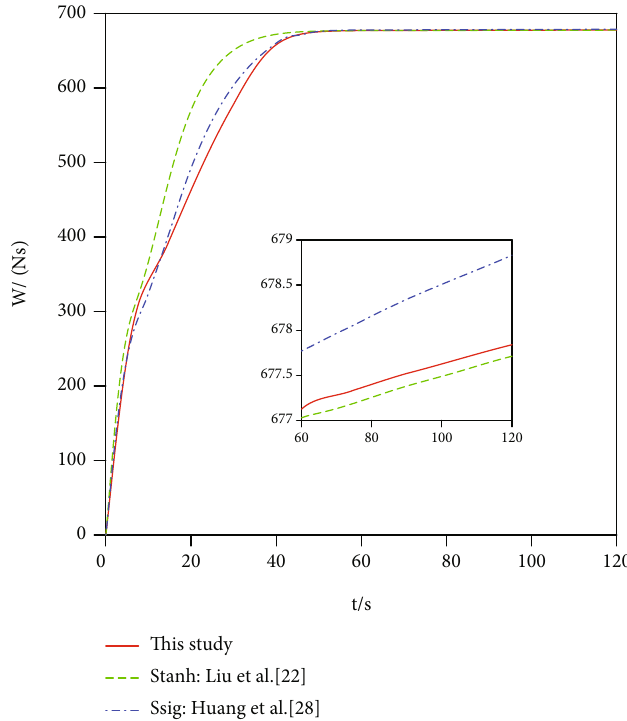
Figure 9: Curves of the integration of control force.